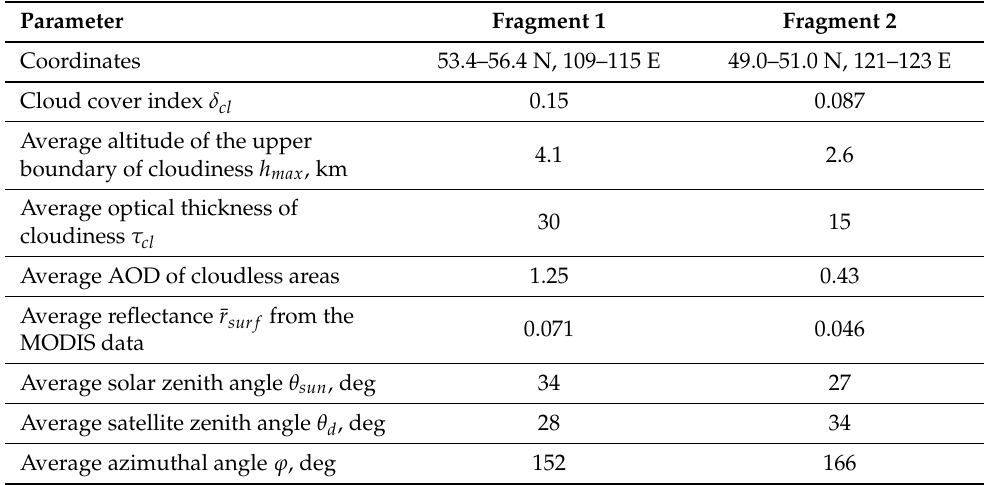
Table 1. Boundaries of the examined image fragments and average optical and geometrical conditions according to the MODIS data.